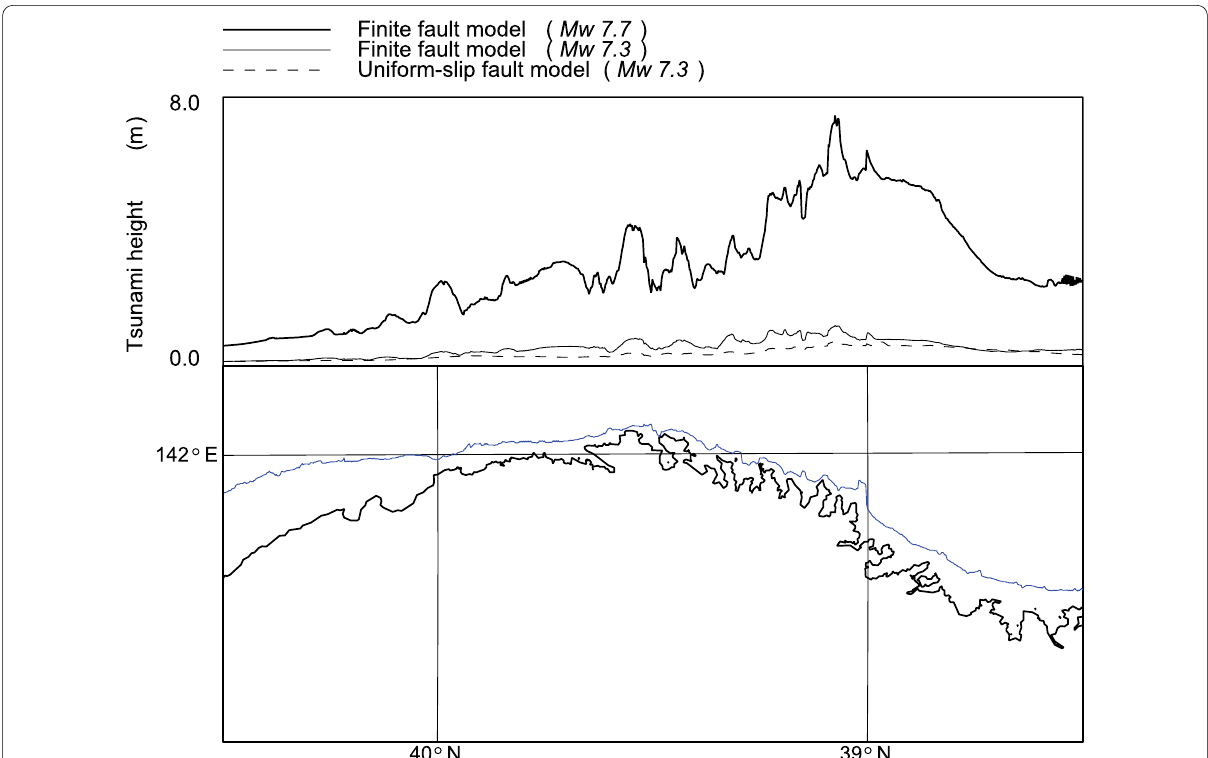
Fig. 10 Comparison of tsunami heights calculated for the finite fault model of the 2006 Java earthquake ( M w 7.7, Fig. 8, the thick solid curve), that of reduced magnitude ( M w 7.3, the thin solid curve), and a uniform-slip fault model ( M w 7.3, the broken curve). Tsunami height was evaluated along water depth of 100 m (blue line on the